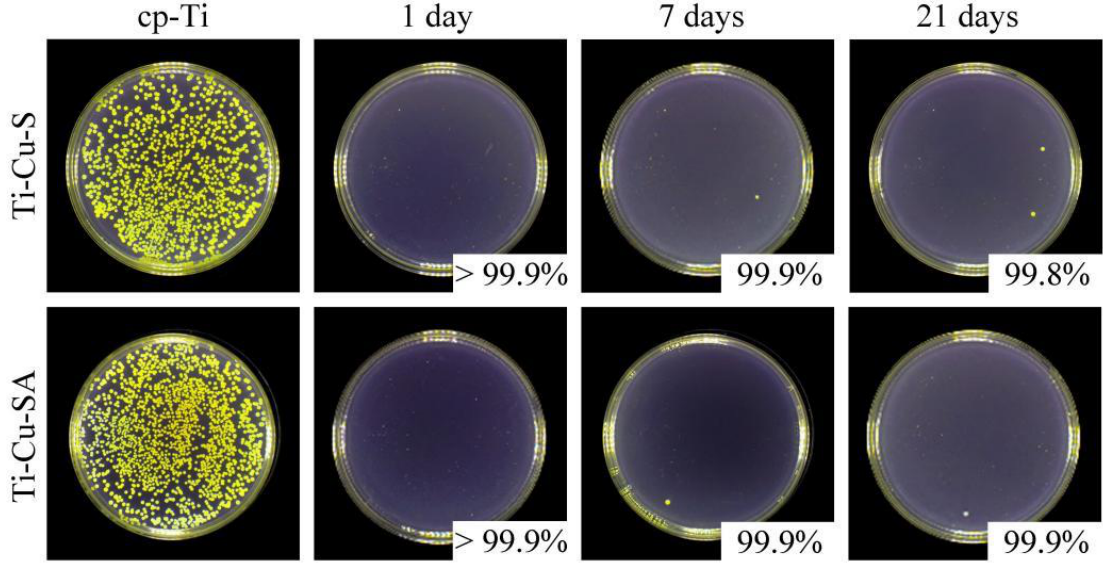
Figure 5. Typical bacterial colonies and antibacterial rates of the samples against S. aureus for differ- ent lengths of